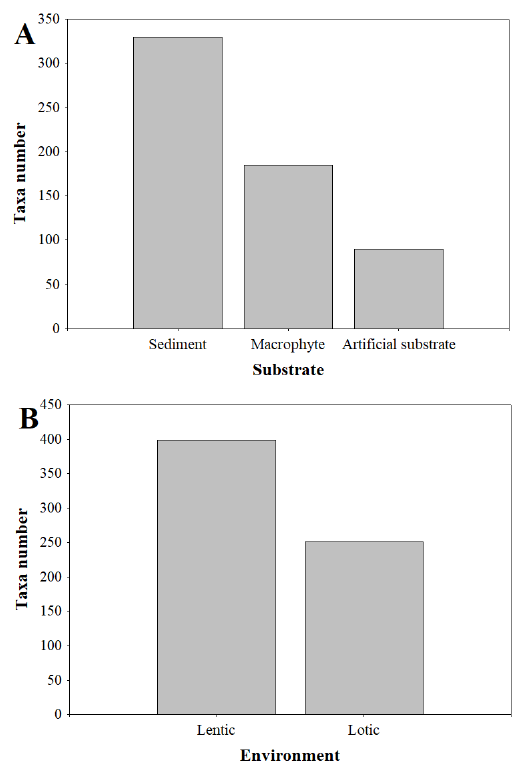
Figure 6. (A) The sum of the observed taxa number per year with its accumulation curve, and (B) Curves of estimated richness and Bootstrap over the sampled random years